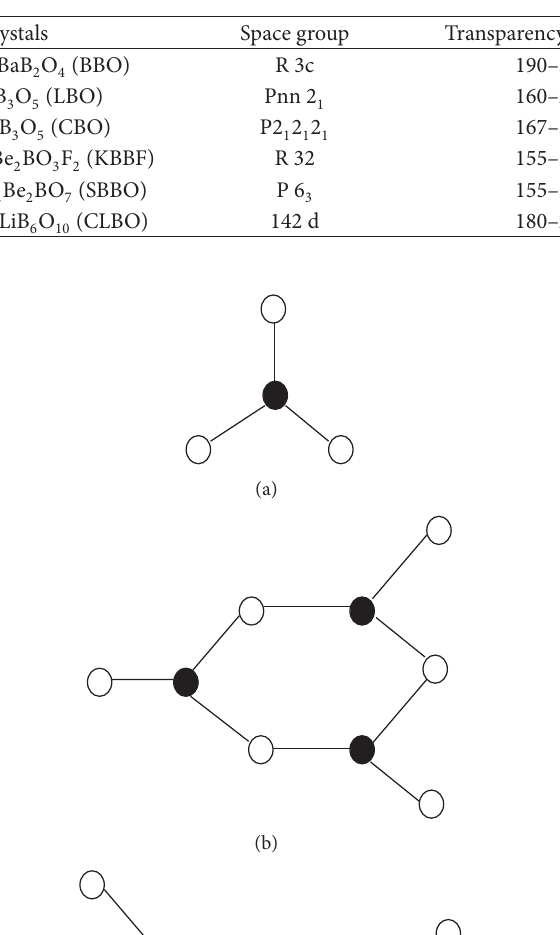
T 1: Selected properties of few borate crystals.